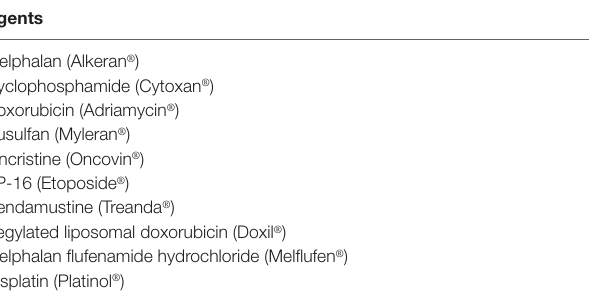
TABLE 1 | DNA-damaging chemotherapeutic drugs used in